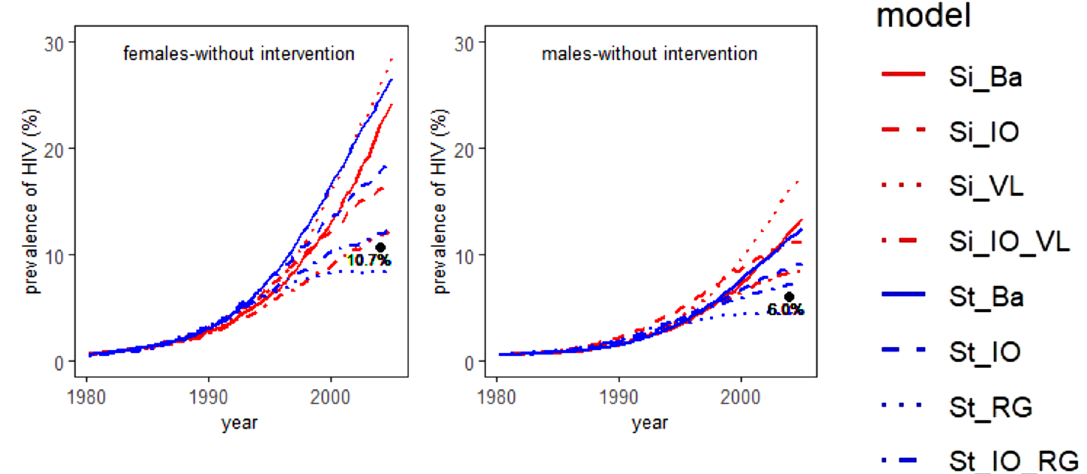
Figure 1. Prevalence curves for HIV from 1980 to 2005 in case no behavioural intervention is implemented. Median HIV prevalence (in %) of 100 simulations. The black dot represents the literature value from Ref. 28 . Left panel: females; right panel: males. Models: Si_Ba: Simpact 1.0 basic model; Si_IO: Simpact 1.0 model with inflow and outflow; Si_VL: Simpact 1.0 model with VL-dependent HIV transmission hazard; Si_IO_VL: Simpact 1.0 model with inflow, outflow, VL-dependent HIV transmission hazard; St_Ba: StepSyn 1.0 basic model; St_IO: Stepsyn 1.0 model with inflow and outflow; St_RG: StepSyn 1.0 model with STI life history explicitly modeled; St_IO_RG: StepSyn 1.0 model with inflow, outflow and STI life history explicitly modeled. Figures were generated using R software version 3.6.0. (R Core Team (2019). R: A language and environment for statistical computing. R Foundation for Statistical Computing, Vienna, Austria (URL https:// www.R- proje ct. org/) 14